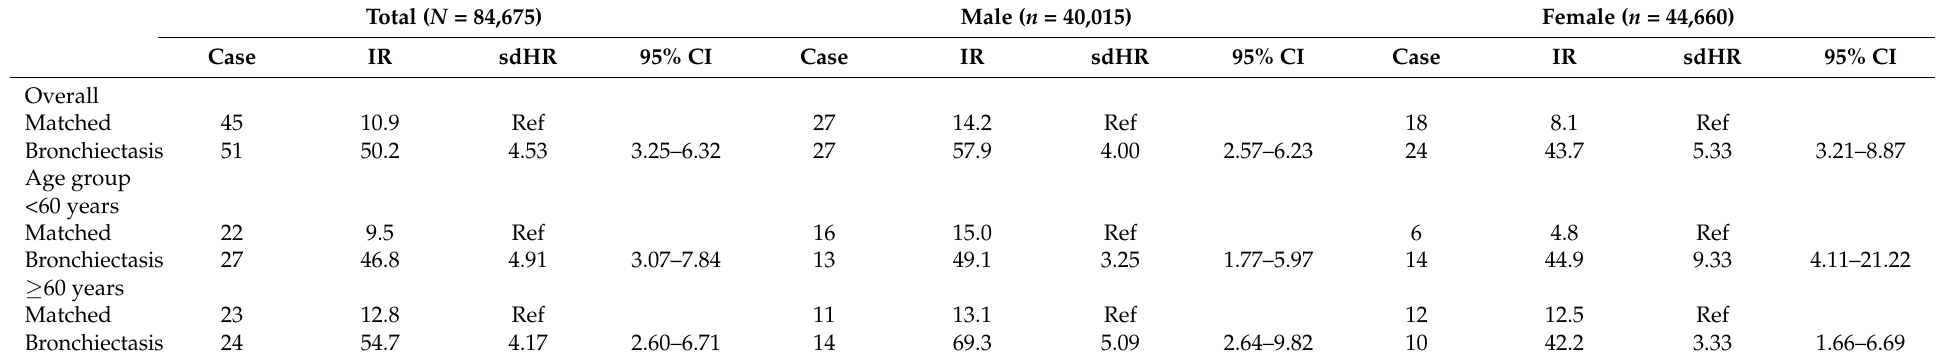
Table 2. Sex- and age-specific incidence rates (/100,000 person-years) and subdistribution hazard ratios of aspergillosis in the bronchiectasis cohort relative to the matched